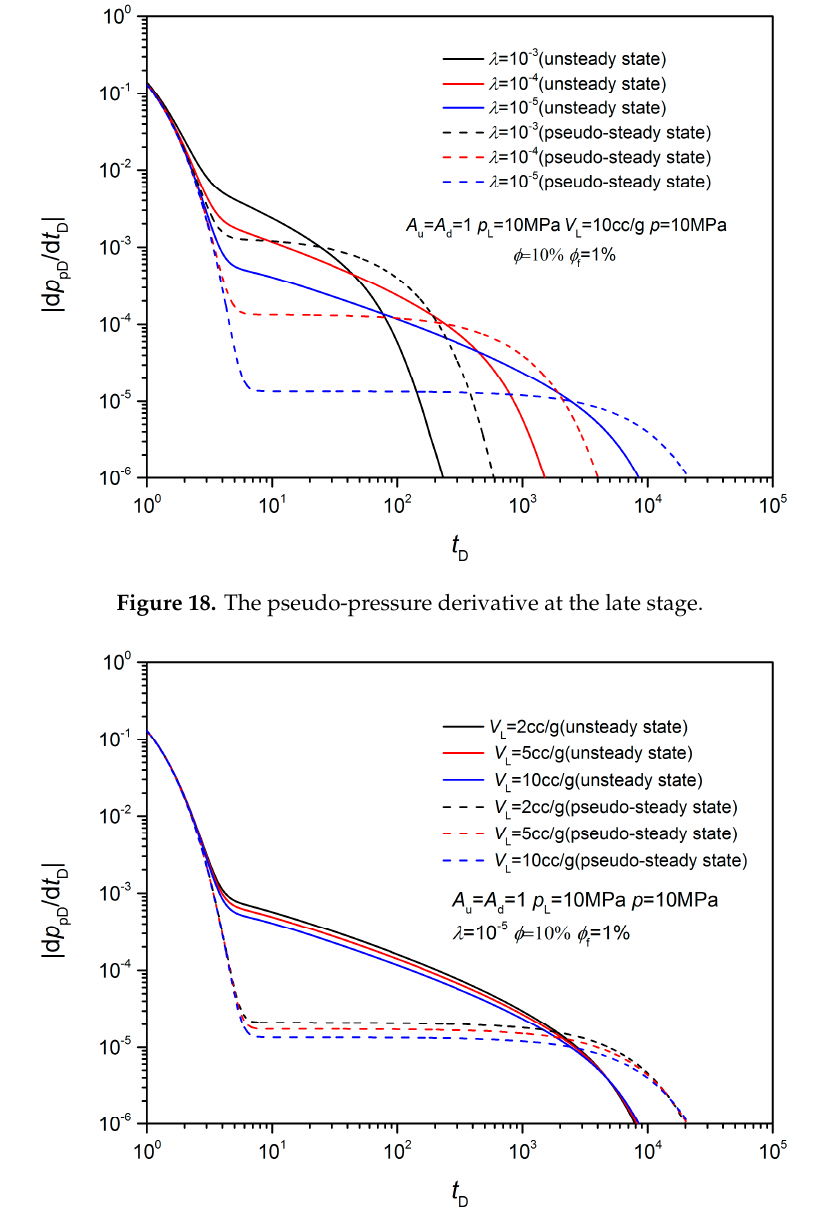
Figure 19. The influence of V L on the pseudo-pressure derivative curves at the late stage.